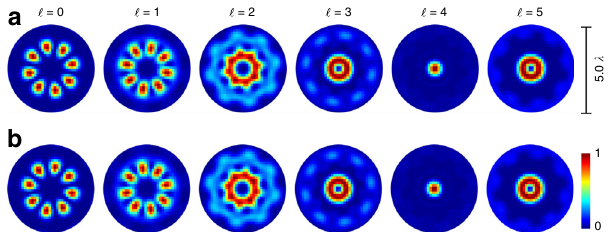
Fig. 4 Numerical evaluation of SAM fl uorescence for paraxial light fi elds. SAM (random d ( x , y ), d z > 0) is examplarily excited by the far fi eld distribution of ( a ) a vectorial fl ower ( σ 12 = + 8) or ( b ) web structure ( σ 12 = − 8) with additional phase vortices of charge ‘ . Total normalized